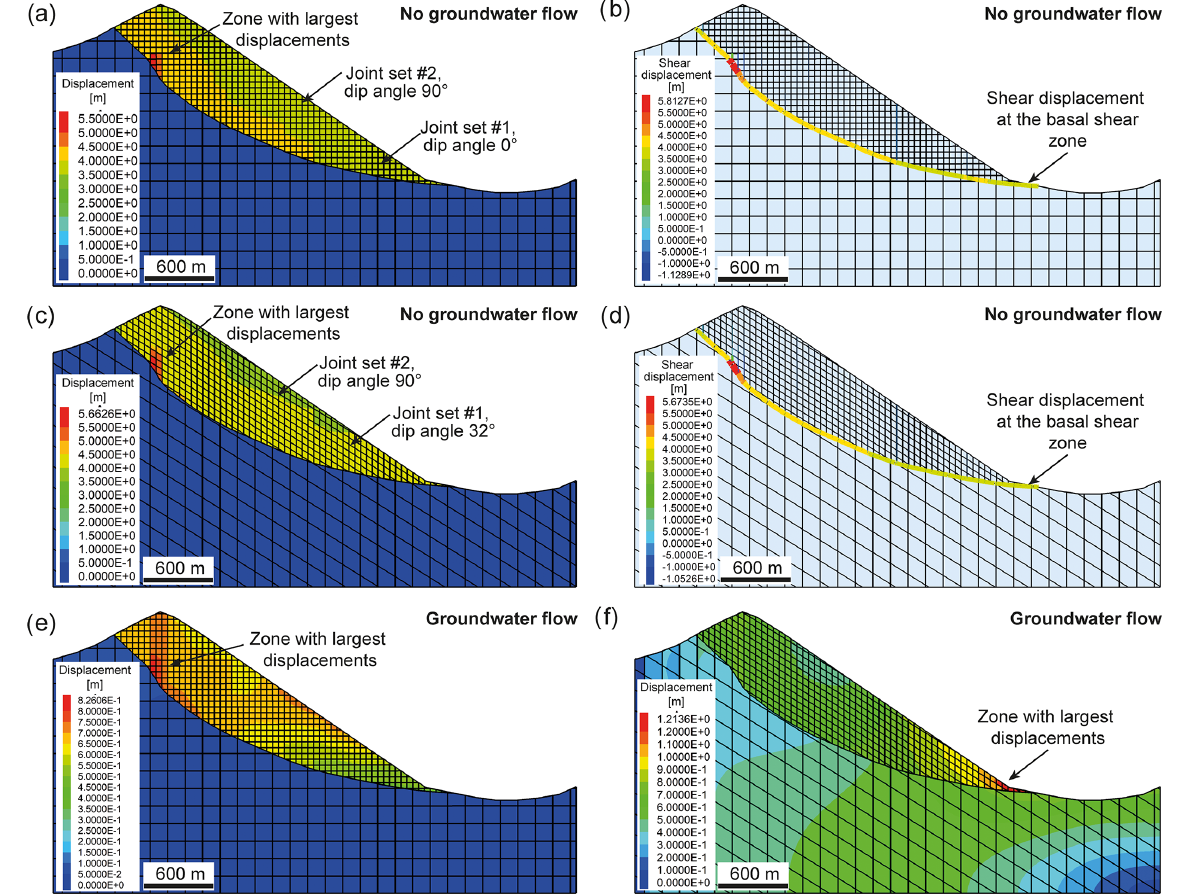
Figure 10. Results of modelling scenario II: (a) internal deformation of the rockslide mass with horizontal and vertical joint sets presented by the maximum block displacements around the steeply inclined section of the basal shear zone, (b) shear displacements along the basal shear zone for the same model type shown in panel (a) , (c) internal deformation of the rockslide mass with horizontal and inclined joint sets presented by the maximum block displacements around the steeply inclined section of the basal shear zone, (d) shear displacements along the basal shear zone for the same model type as in (c) , and (e) internal deformation of the rockslide mass with horizontal and vertical joint sets when groundwater flow is considered. Similar to dry conditions, maximum block displacements were calculated near the steeply inclined section of the basal shear zone, and (f) internal deformation of the rockslide mass with horizontal and inclined joint sets when groundwater flow is considered. Maximum block displacements were calculated near the foot of the